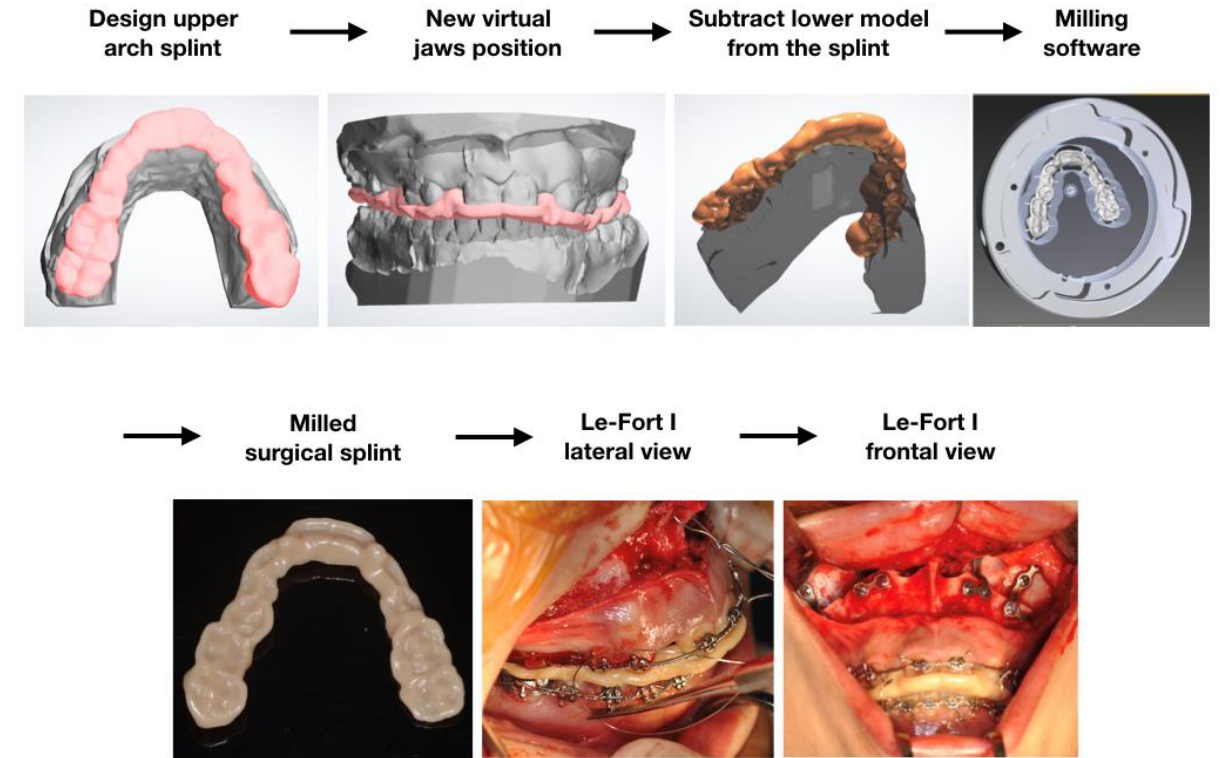
Figure 17. Example of digital workflow for the production of surgical splint (3Shape, Copenhagen, Denmark) and clinical application.